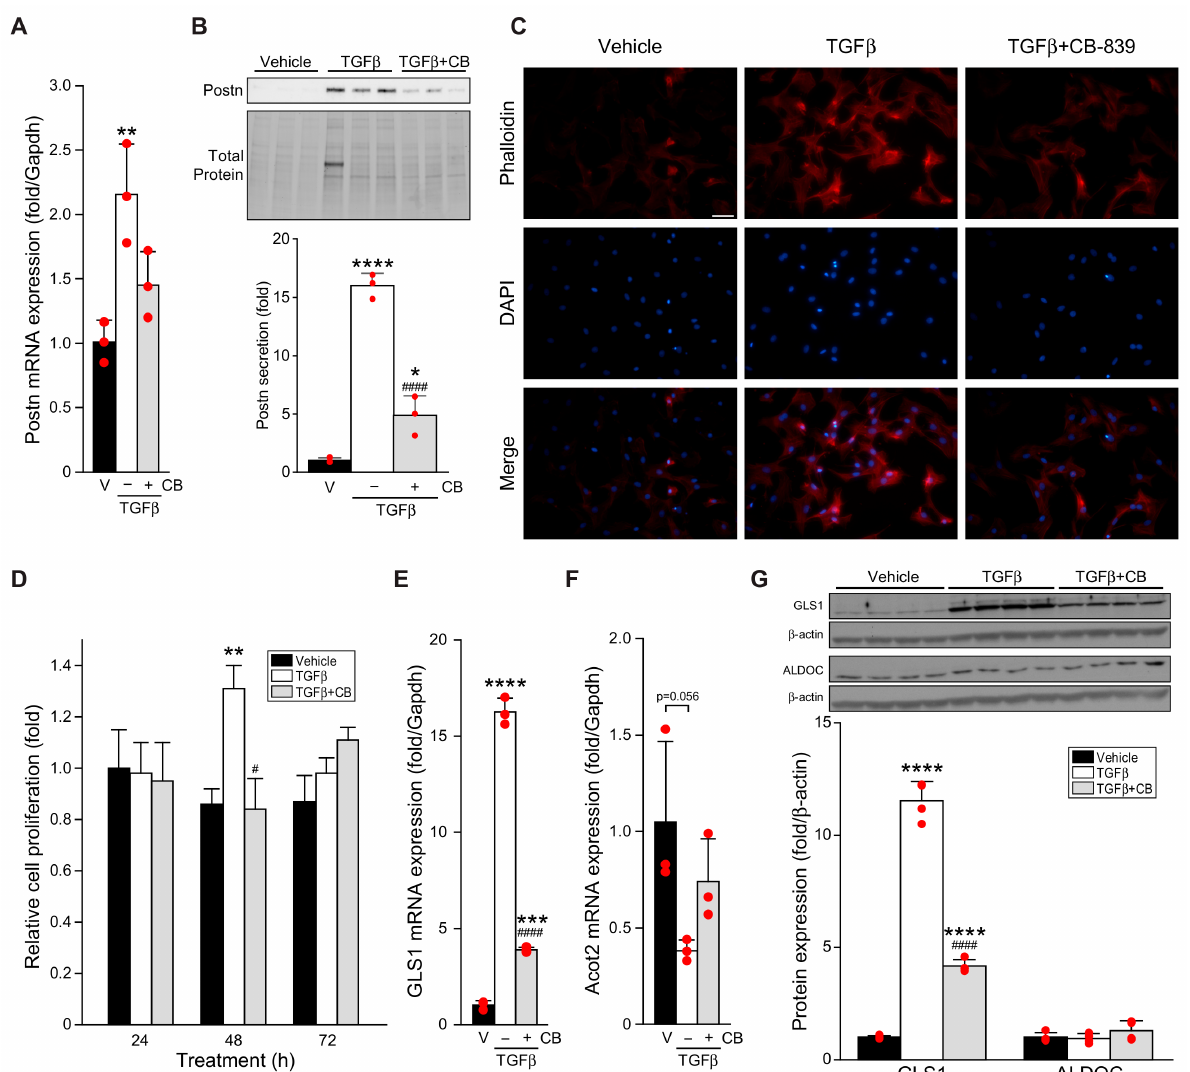
Figure 1. TGF β -induced fibroblast activation and GLS1 expression is attenuated by CB-839. ( A – F ) Rat cardiac fibroblasts were treated for 24 h with vehicle (V) or 10 ng/mL TGF β 1 , with or without GLS1 inhibitor CB-839 (CB, 0.3 µ M), then assayed for expression of periostin (Postn) mRNA by qPCR ( A ), secretion of Postn ( B ), development of stress fibers ( C ), proliferation ( D ), and expression of GLS1 ( E ) and Acot2 mRNA by qPCR ( F ). In a similar experiment, protein expression of GLS1 and aldolase C (ALDOC) was assessed by Western blot ( G ). Statistical significance was determined by one-way ANOVA with the Tukey post hoc test (n = 3–4) ( A , B , E – G ), or by the Kruskal–Wallis test followed by Dunn’s multiple comparisons test ( D , n = 16–18; ALDOC in G , n = 4); images in ( C ) are representative of four independent experiments. * p < 0.05, ** p < 0.01, *** p < 0.001, **** p < 0.0001 versus vehicle; # p < 0.05, #### p < 0.0001 versus TGF β . Scale bar in ( C ), 50 µ